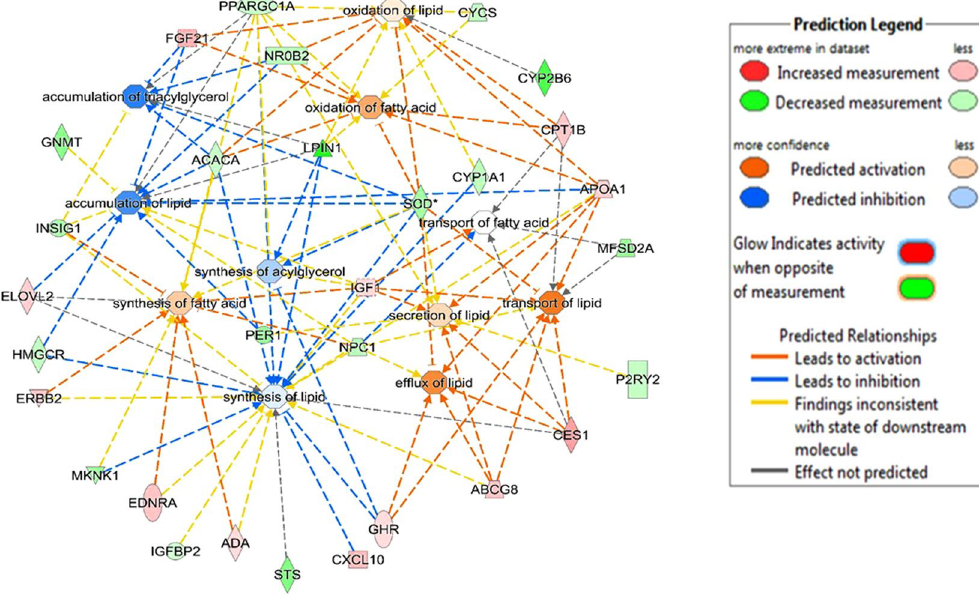
Figure 5. Metabolic process regulatory gene network showing differentially expressed (DE) genes involved in the different lipid metabolic processes and their predicted activation or deactivation levels in KC low-RFI